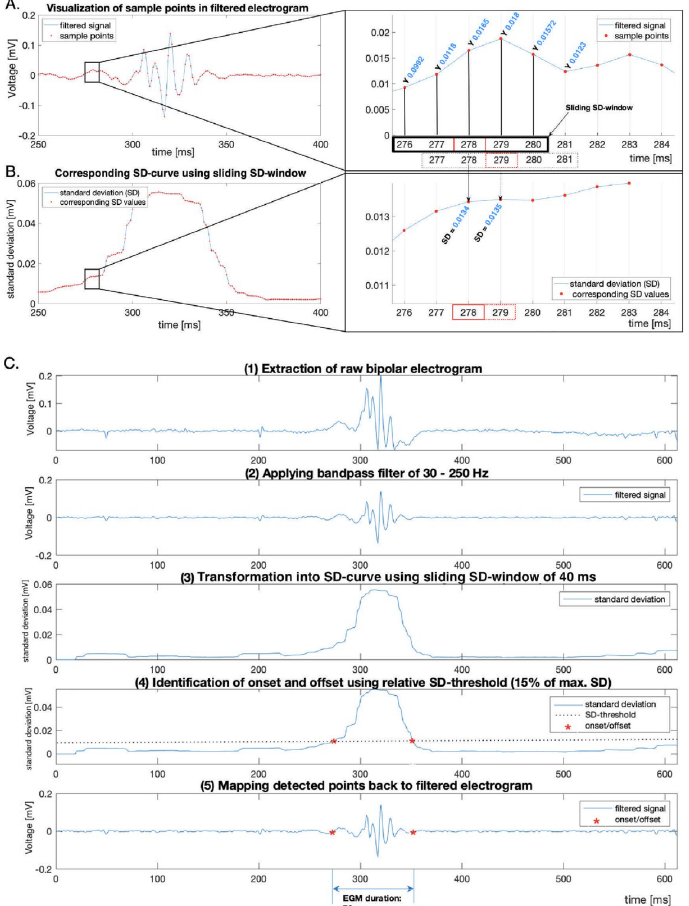
Fig 2. Method and schematic visualization of electrogram duration estimation using sliding SD-window and SD- threshold. (A) Visualization of filtered electrogram with its sample points (red dots) recorded with bipolar electrodes from a single beat. Sample points with corresponding local voltage are displayed at a rate of 1 millisecond (left). Magnification of the labelled interval (right). A sliding standard deviation (SD) window was applied to calculate SD over a moving window (black box) of predefined length across neighboring sample points. The dotted box indicates the method of consecutive SD value determination. (B) The corresponding SD values generate the SD-curve for further signal processing (left). Magnification of the labelled interval (right). The calculated SD value corresponds to a specific time unit (red box) in the moving window and is transformed into SD-curve. (C) Schematic visualization of workflow of signal processing parameter estimating EGM duration. After extraction of the raw bipolar electrogram during sinus rhythm (1), a bandpass filter of 30–250 Hz was applied (2). A sliding SD-window of 40 ms length calculates the SD across the electrogram (3). Onset and offset (red stars) were detected when 15% of the maximum SD (dotted line) was reached (4). Detected points (red stars) were transferred to the initially filtered electrogram to demonstrate onset and offset. The interval between onset and offset results in an EGM duration of 76 ms